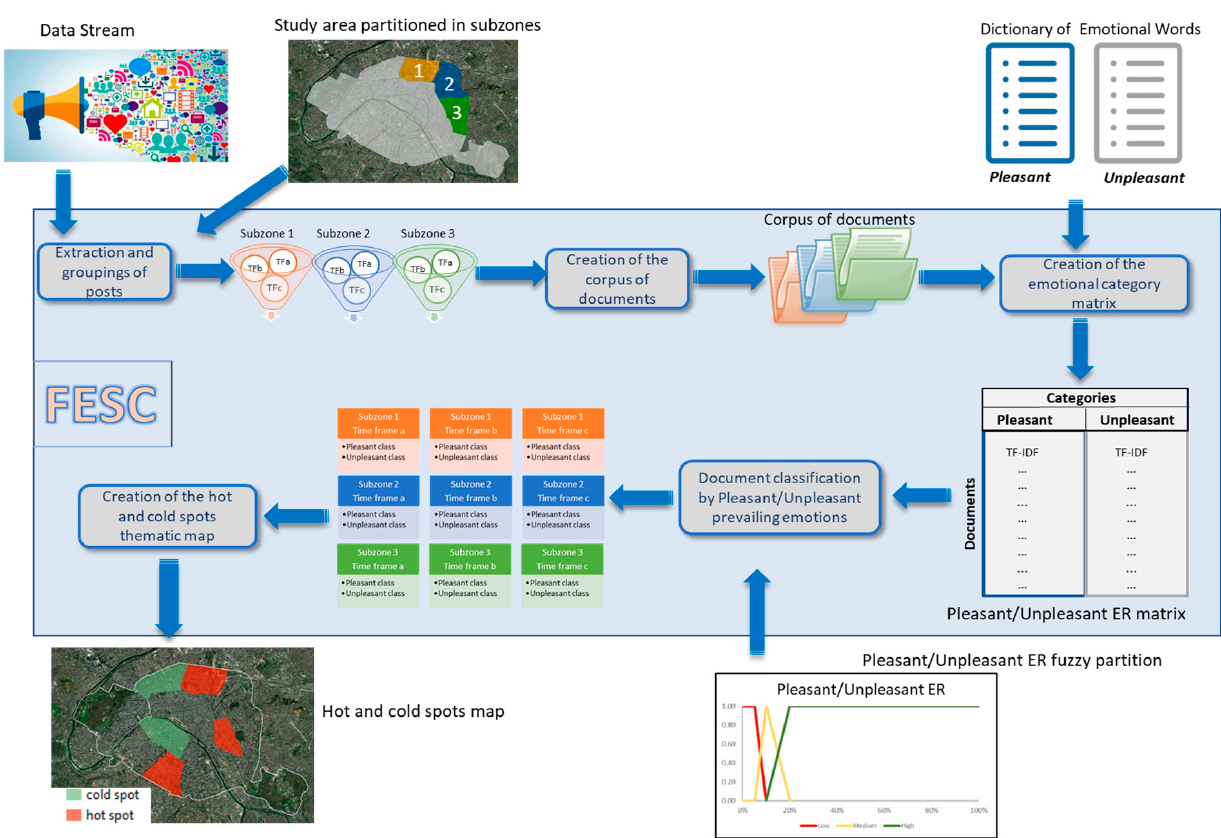
Figure 2. Schema of the proposed GIS-based framework. Inputs for the framework are the study area divided into subzones, the data stream with the posts entered by citizens in the analyzed period, the Dictionary of the Emotional Word containing the dictionary of terms relating to the single emotional categories, and the ER fuzzy